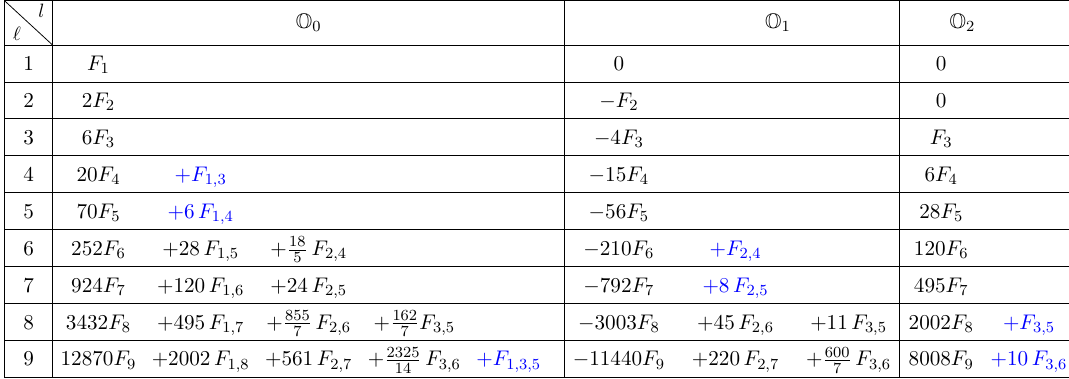
( − g 2 ) i 1 + ··· + i n (1 − d ) n F . We highlight the i 1 , ··· ,i n → 13 d 24 i 1 , ··· ,i n